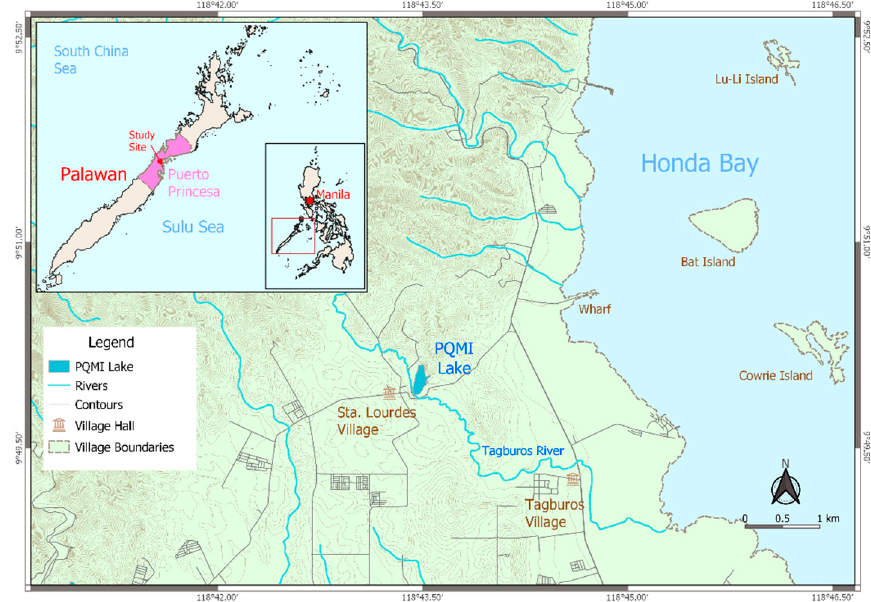
Figure 1. Map of the study site showing the rivers, pit lake, and Honda Bay, with a map of the Philippines and Palawan island (inset).